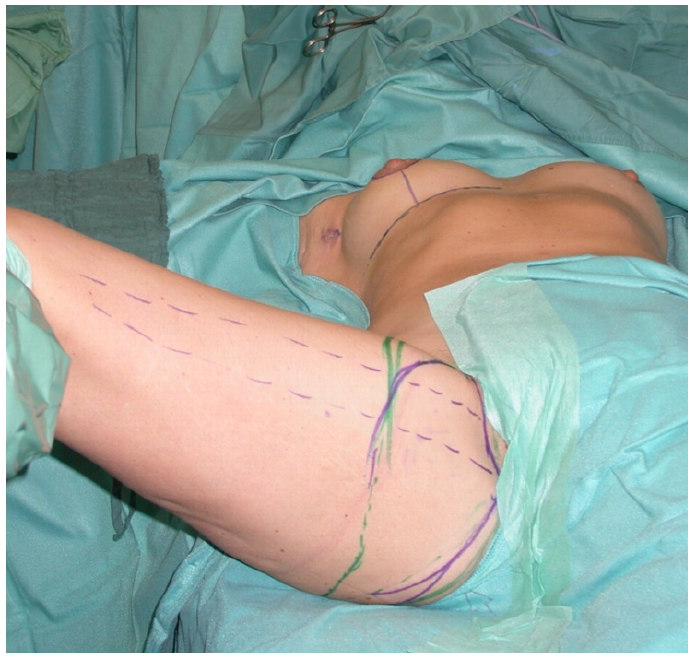
Figure 1. Intraoperative image at the beginning of the operation.